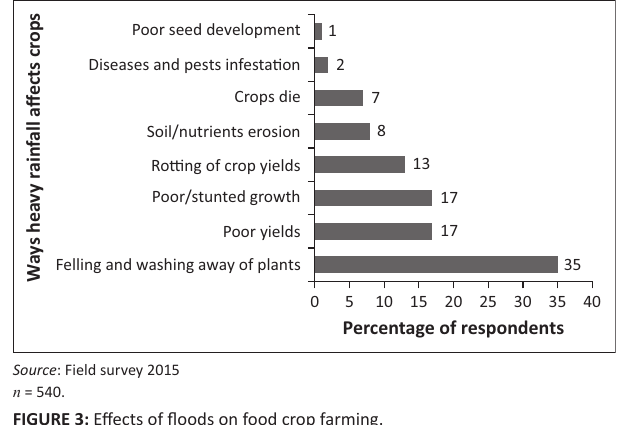
FIGURE 3: Effects of floods on food crop